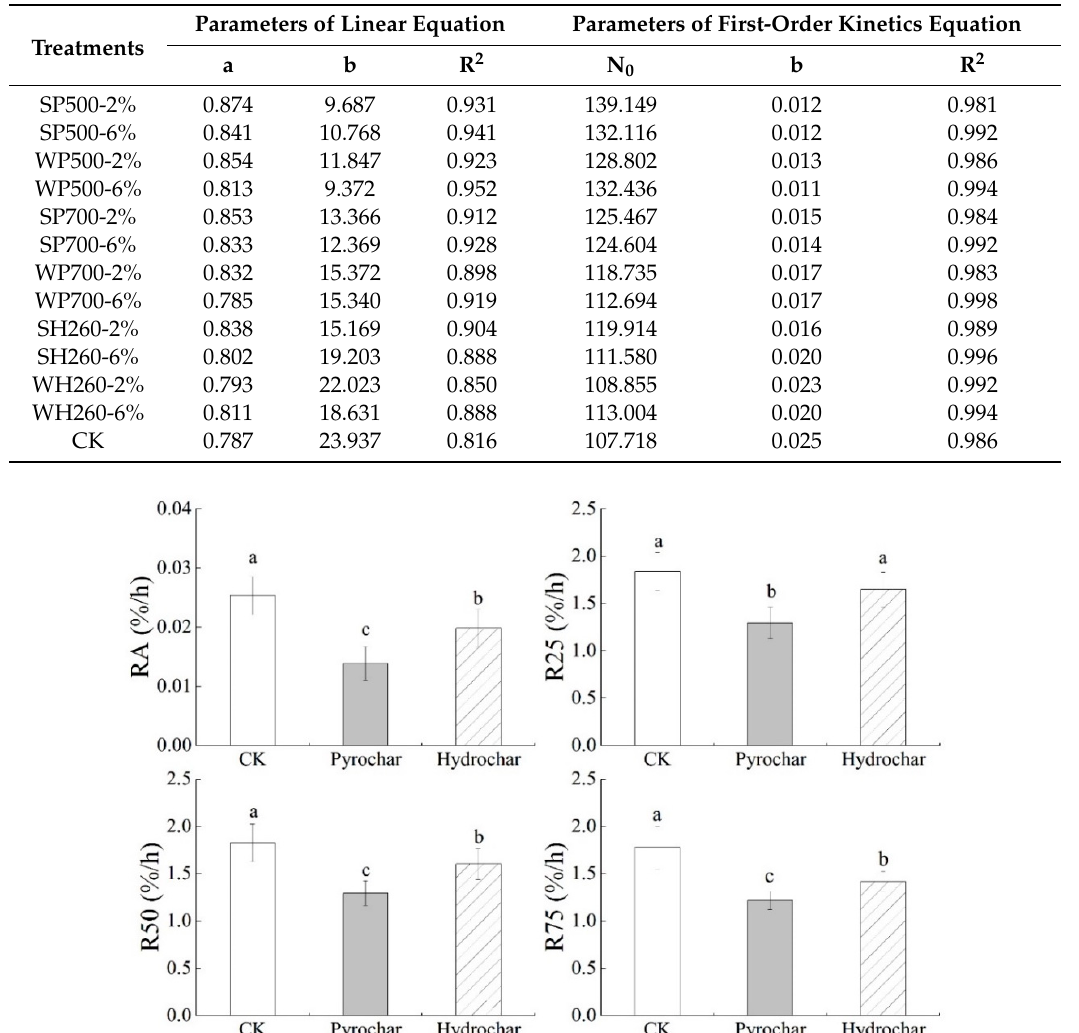
Table 2. Parameters of the fitting equation of soil evaporation curves under pyrochar and hydrochar application.